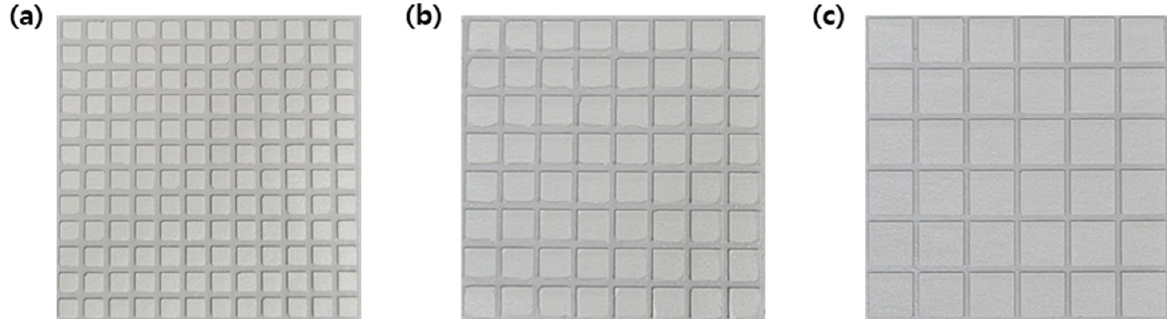
Figure 6. Digital photos of h-BN pattern/c-Al films fabricated using the metal masks with open areas of ( a ) 3 mm × 3 mm, ( b ) 5 mm × 5 mm, and ( c ) 7 mm × 7 mm. The space between patterns was 1 mm. Table 2. The Al 2 O 3 and h-BN contents of the Al/h-BN/Al composites. Composites Al 2 O 3 (wt.%) h-BN (wt.%)